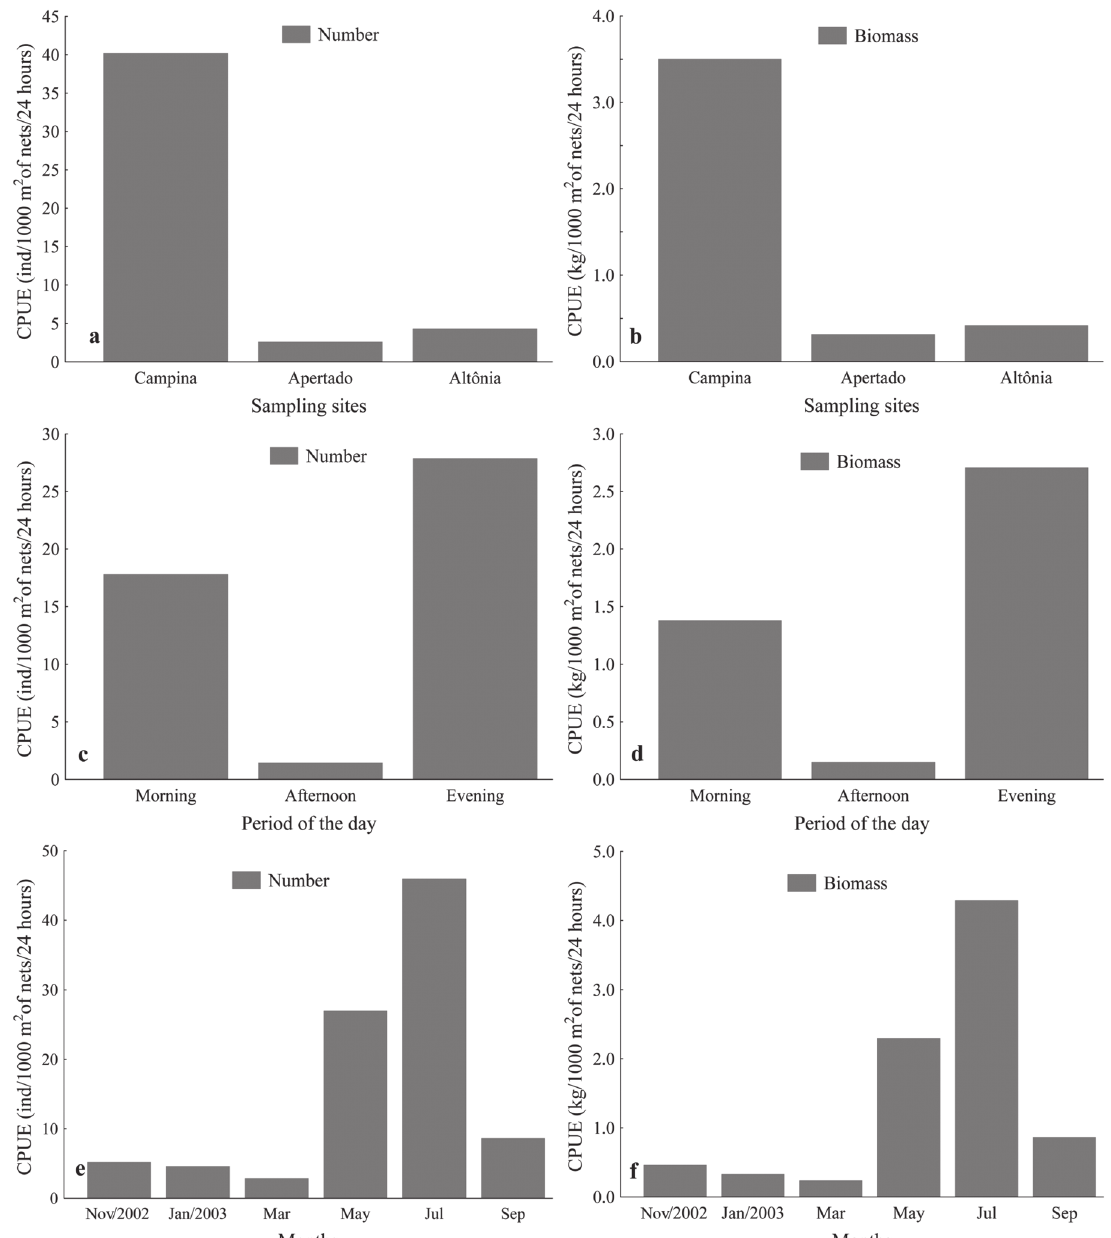
Fig. 2. Catch per unit of effort, in number and biomass (number of individuals and kg/1000 m 2 of net for 24 hours) of Iheringichthys labrosus , obtained at the sampling sites (a - number of individuals, b - biomass); shifts (c - number of individuals, d - biomass) and months (e - number of individuals, f - biomass) in the Piquiri River from November 2002 to September 2003. Table 1. Sex ratio of Iheringichthys labrosus and the chi-square test ( χ 2 ) from November 2002 to September 2003 in the